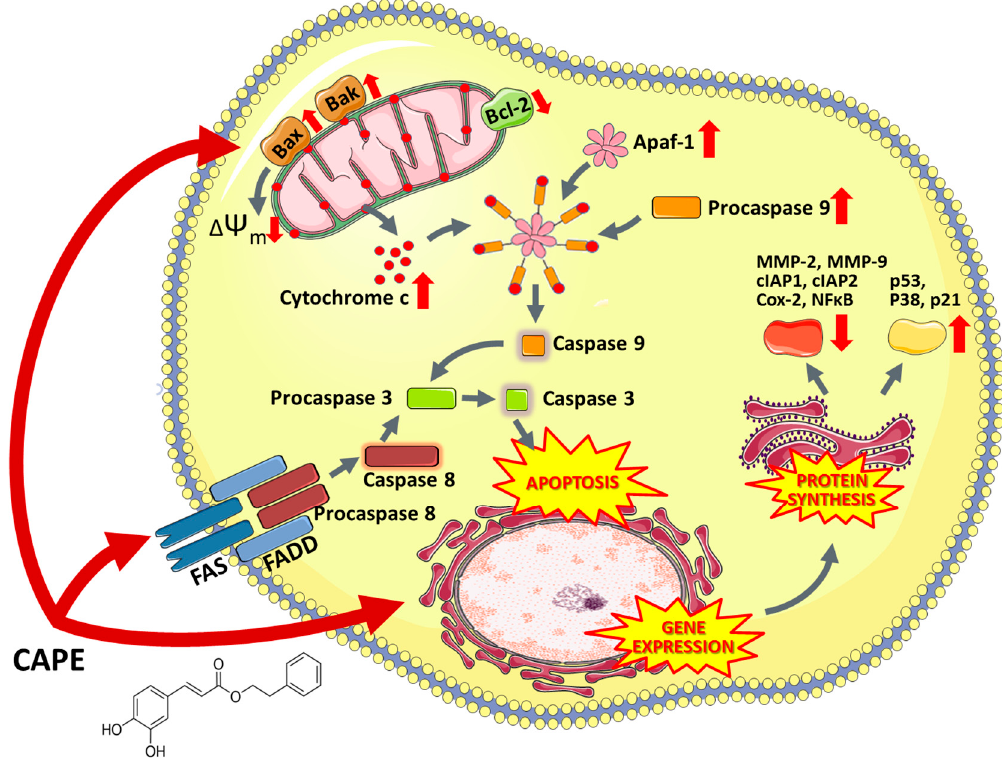
Figure 5. Mechanism of action of CAPE (Caffeic acid phenethyl ester) in cancer cells. ΔΨ m—Mitochondrial membrane potential, Apaf-1—Apoptotic protease activating factor, Bak—Bcl-2-antagonist killer, Bax—bcl-2-like protein 4, Bcl-2—B-cell lymphoma 2, cIAP1—Cellular